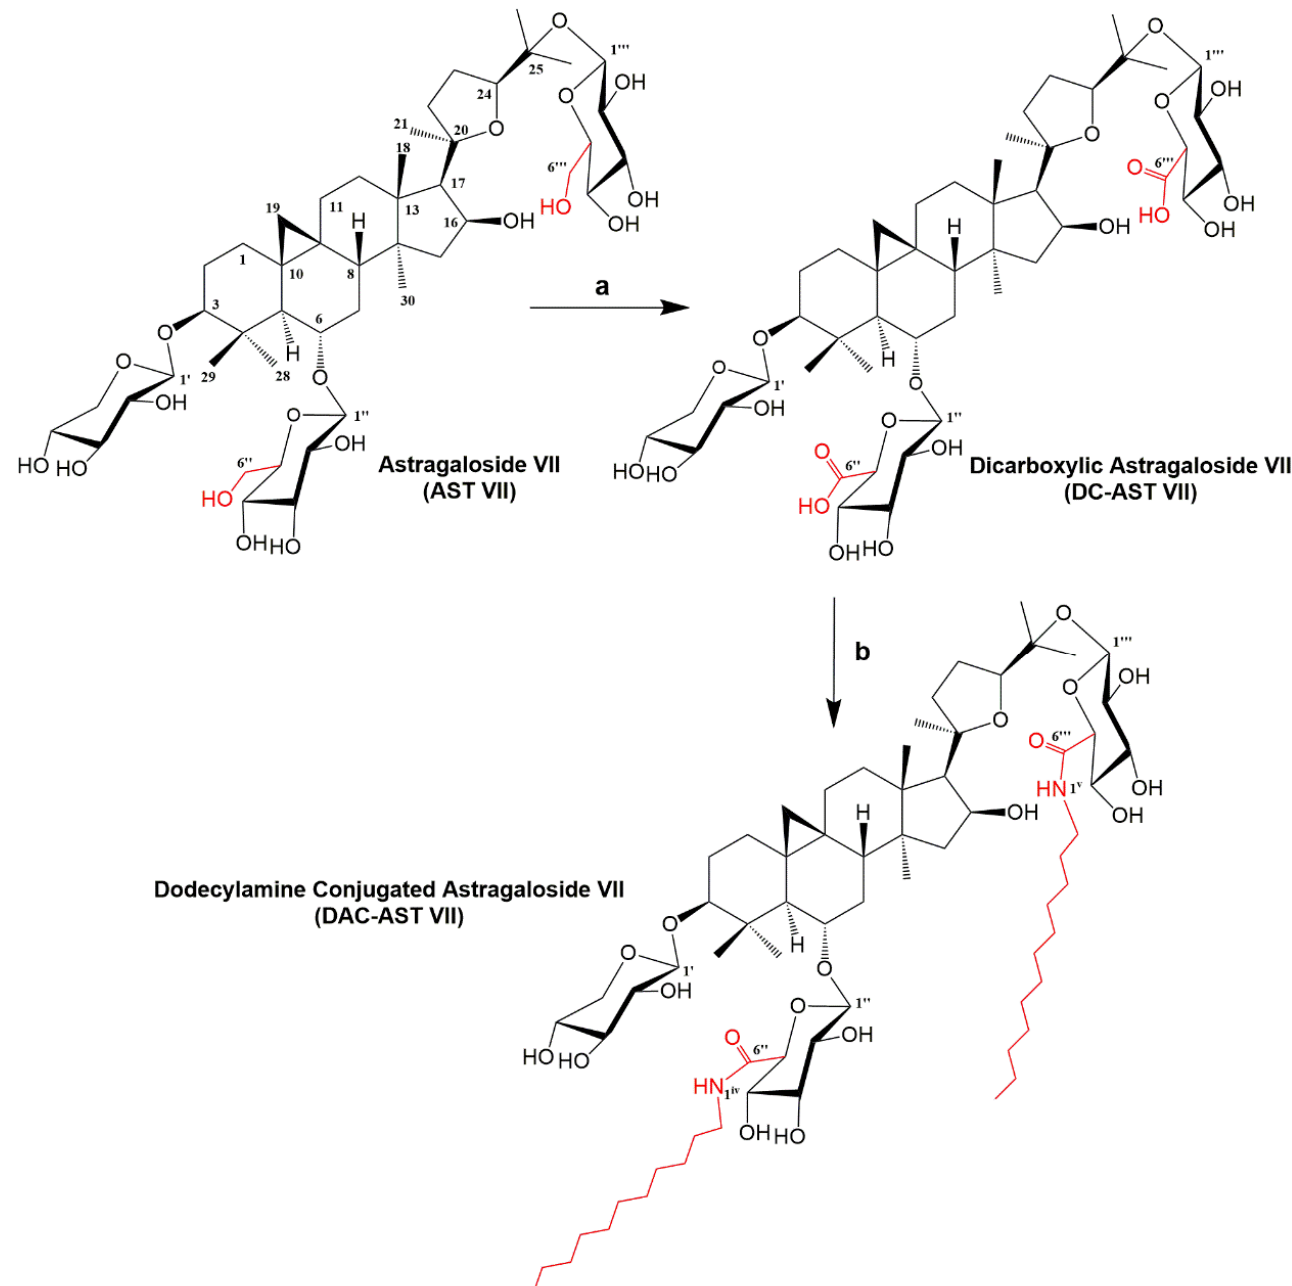
Figure 1. Semi-synthesis of AST VII derivatives. Reagents and conditions: ( a ) TEMPO, NaBr, NaOCl, H 2 O, 0 °C (57%) and ( b ) EDC/HOBt, DIPEA, Pyridine, 60 °C (28%).